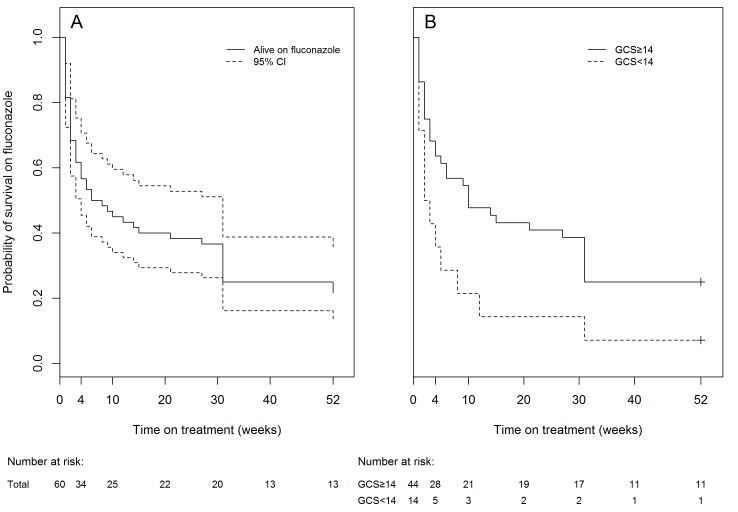
A shows survival on fluconazole therapy for all 60 patients.The solid line shows estimated proportion of survivors and the dotted lines show 95% confidence intervals. Amongst the 47 patients who did not survive on fluconazole to 52 weeks, two had positive CSF cultures at 10 weeks and were switched to fluconazole. The remaining 45 died. B shows survival on fluconazole stratified by baseline GCS. 2 patients (one who died in the first week and one who survived to 52 weeks) were excluded from this analysis as no baseline GCS was recorded. The solid line represents patients with baseline GCS≥14 and the dotted line represents patients with baseline GCS<14. Hazard ratio for death or treatment failure by 52 weeks: 2.09, 95% CI: 1.07–4.06 p = 0.030.